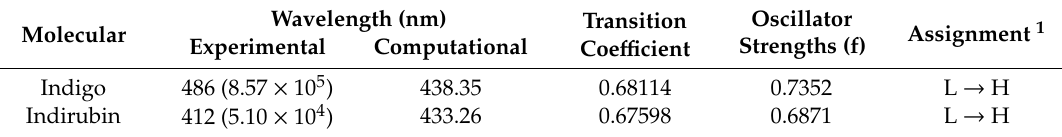
Figure 7. Fluorescence spectra of indigo ( a ) and indirubin ( b ). Table 5. Theoretical electronic emission spectra of indigo and indirubin computational at the B3LYP/6-311G(d,p) level of theory.